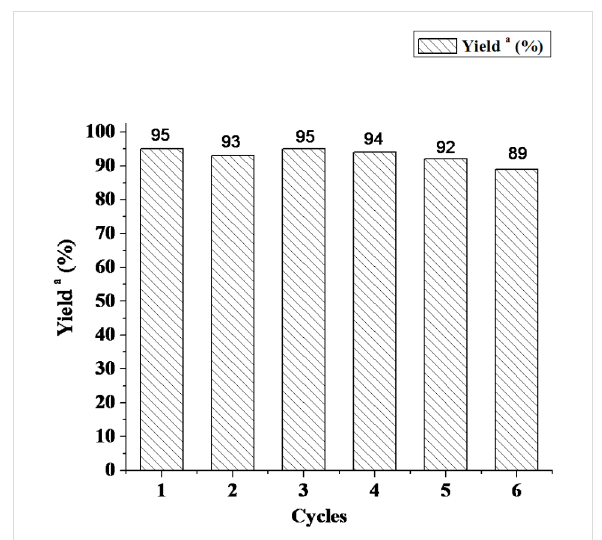
Figure 5: Recycling of Cell–OPPh 2 –Pd 0 for the Suzuki reaction. Reac- tion conditions: 4-iodoanisole (1.0 mmol), phenylboronic acid (1.2 mmol), K 2 CO 3 (2.0 mmol), Cell–OPPh 2 –Pd 0 (0.015 g, 0.005 mmol of Pd), and 5.0 cm 3 95% ethanol heating under reflux in air. a Isolated yield based on